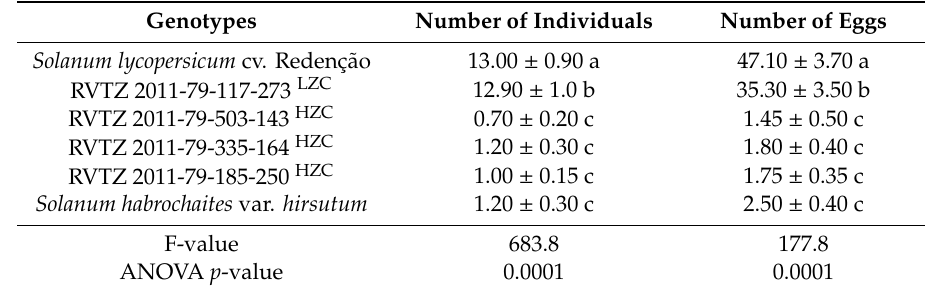
Table 3. Number (± standard error) of Bemisia tabaci live adults and eggs on the abaxial face of leaflets from tomato genotypes in the choice bioassay ( n = 10).